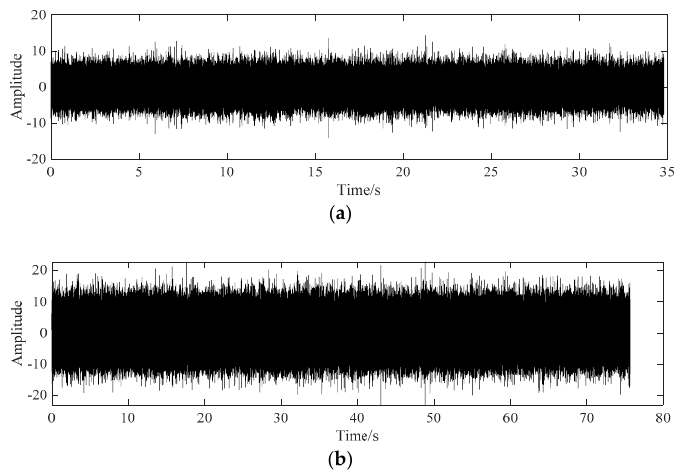
Figure 14. The domain diagram of fault bearings. ( a ) Time domain diagram of outer ring fault. ( b ) Time domain diagram of rolling element fault.